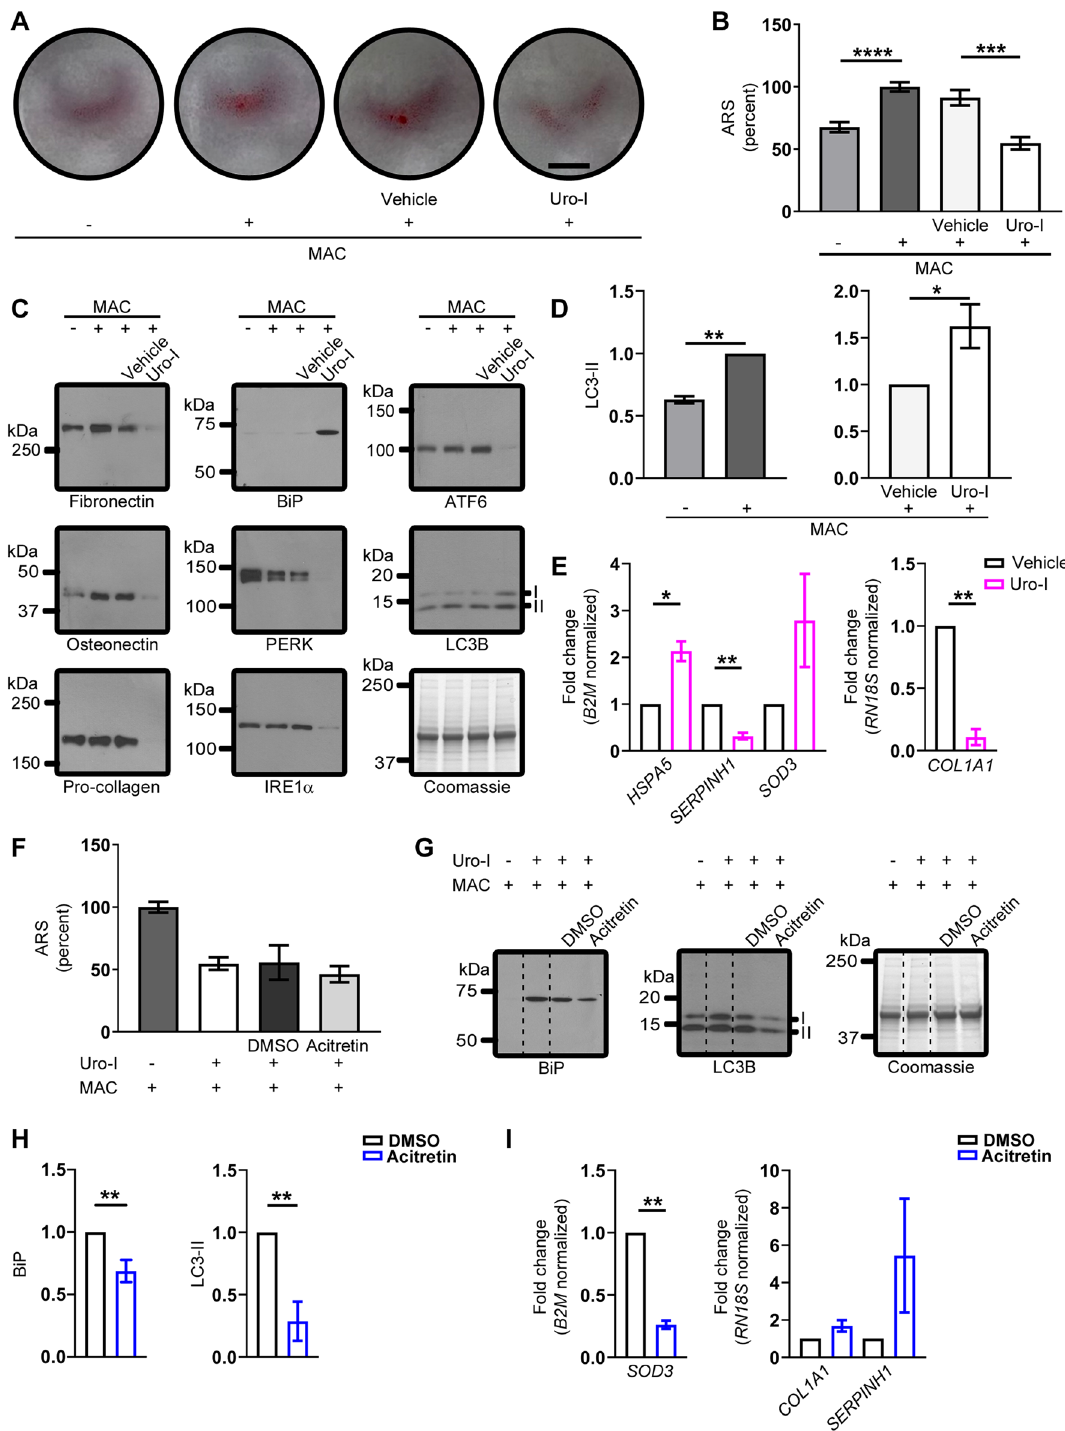
Figure 3. Saos-2 cells mimic CEP zebrafish model. ( A, B ) Mineralization in Saos-2 cells treated with MAC ± Uro-I was assayed using ARS staining (photograph, A; quantification, B). Staining was normalized to MAC only-treated cells (set to 100%). ( C ) Cell lysates from experiment in ( A ) were blotted with the indicated antibodies. ( D ) Quantification of LC3-II shown in (C). LC3-II level was normalized to MAC only (left panel) or vehicle-treated (right panel), set to 100%. ( E ) RT 2 Profiler PCR Array (left panel) and qPCR (right panel). Relative gene expression is represented as fold change normalized to housekeeping gene. Data are from 2 independent experiments. ( F ) Acitretin does not rescue reduced mineral matrix phenotype in uro-I-treated cells. ARS staining quantification as in ( B ). ( G ) Acitretin normalizes ER stress (BiP) and autophagy (LC3-II) markers. Dashed lines represent non-adjacent lanes in the gel. Coomassie-stained gel (C,G) shows equal protein loading. Full-length blots and gels (C,G) are presented in Fig.S4. ( H ) Quantification of LC3-II. LC3-II level was normalized to DMSO-treated cells set to 100%. ( I ) Gene expression profiling as in (E). * p < 0.05, ** p < 0.01, *** p < 0.001, **** p <